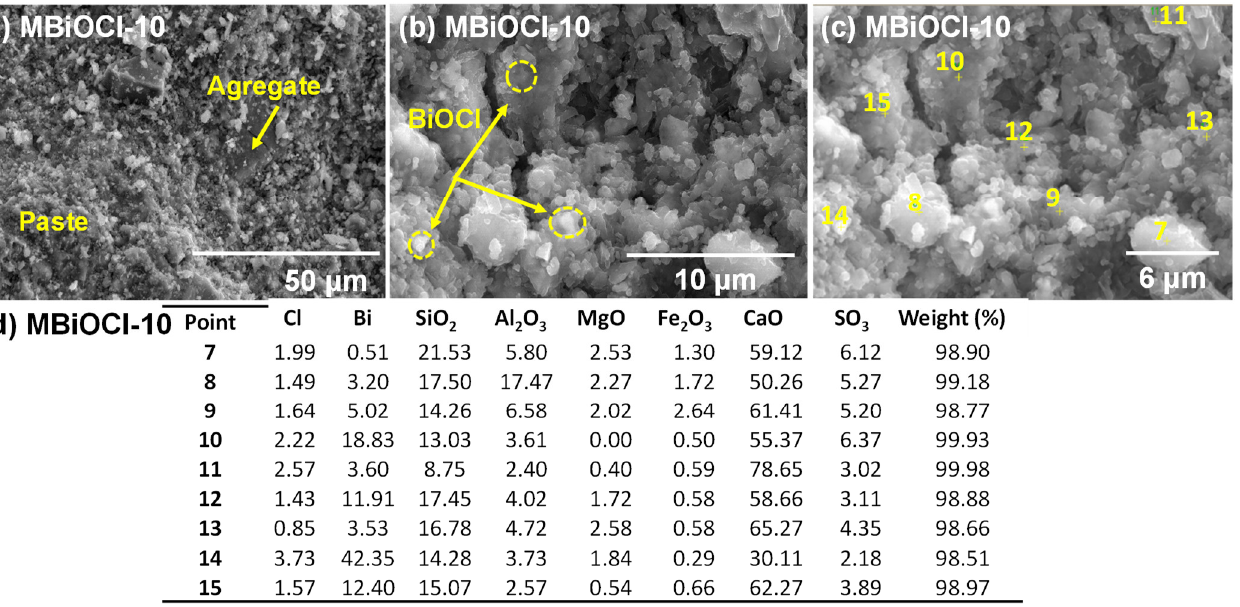
Figure 8. SEM images ( a – c ) and EDS microanalysis ( d ) of MBIOCl-10 mortar at 28 days.